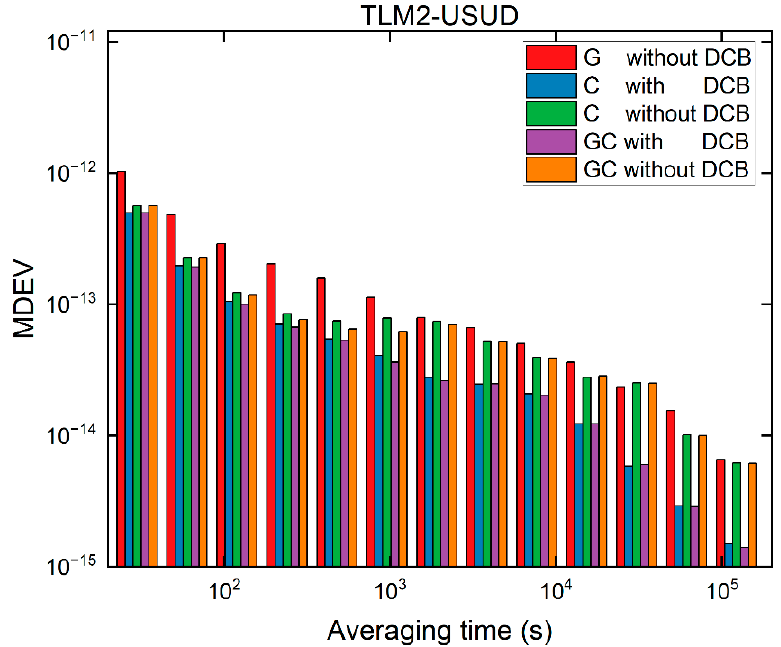
Figure 13. The TCH results for the TLM2-USUD time link. To verify the previous findings, the number of satellites involved in B2b-RTPPP at a cut-off elevation angle of 10 ◦ for the TLM2 and USUD stations during the test